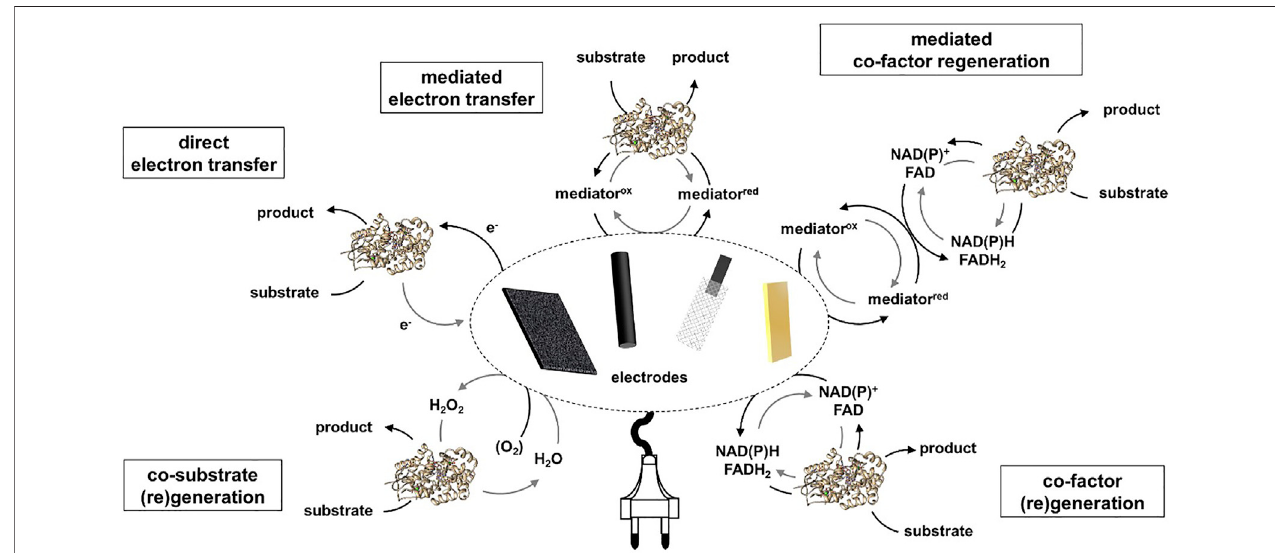
FIGURE 3 | Overview of typical electroenzymatic